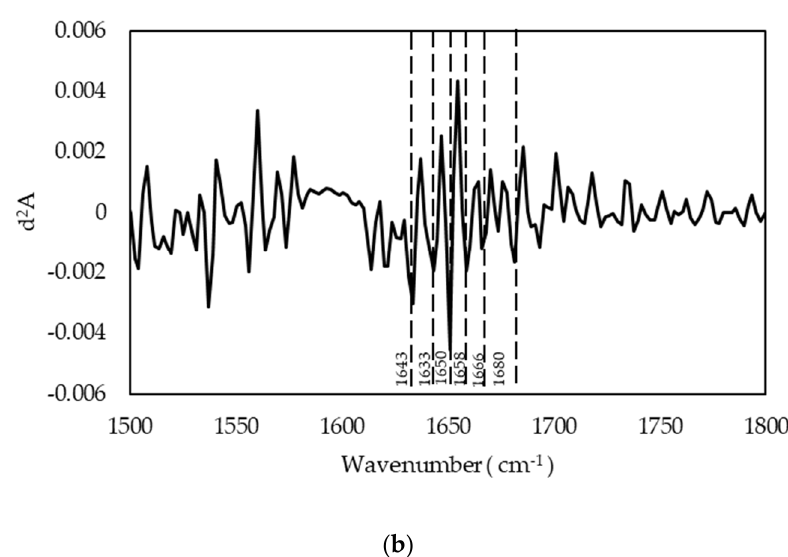
Figure 3. FTIR spectra of salmon gelatin P1 ( a ), and spectra of the second derivative (differential FTIR spectra, with FDD method) in the absorption region of Amide I ( b ).